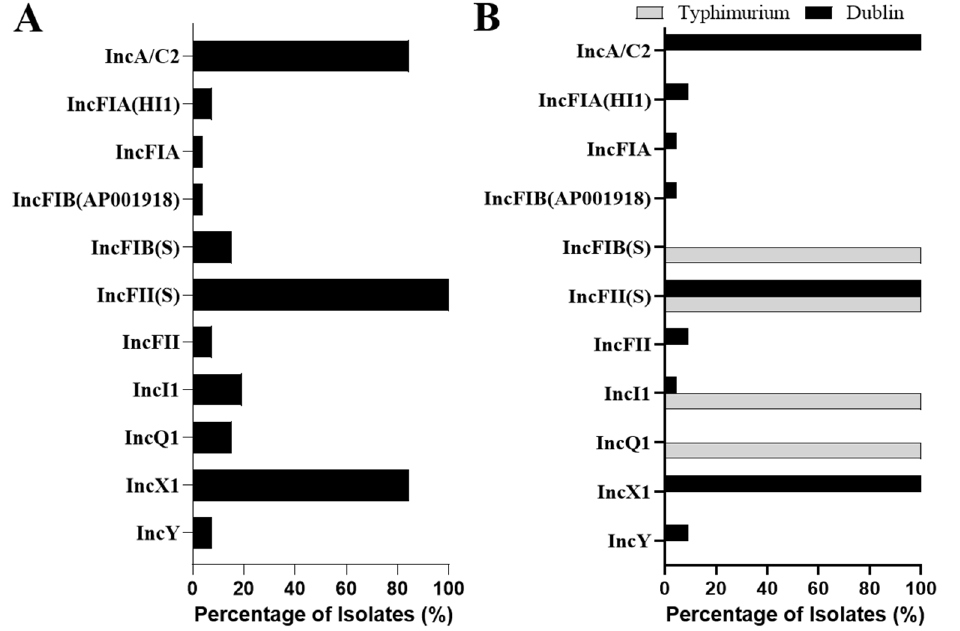
Figure 2. Versatile plasmid replicon types identified in companion-animal-origin Salmonella isolates. ( A ) Percentage of Salmonella isolates carrying diverse plasmid replicon types. ( B ) Distribution of plasmid replicon types in Salmonella Dublin and Salmonella Typhimurium.